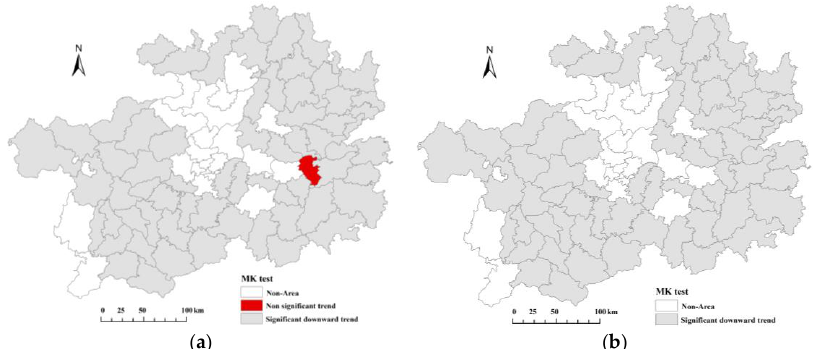
Figure 3. MK statistical test of the poverty-stricken counties in 2003 – 2007 and 2011 – 2017. ( a ) 2003 – 2007 ( b ) 2011 –